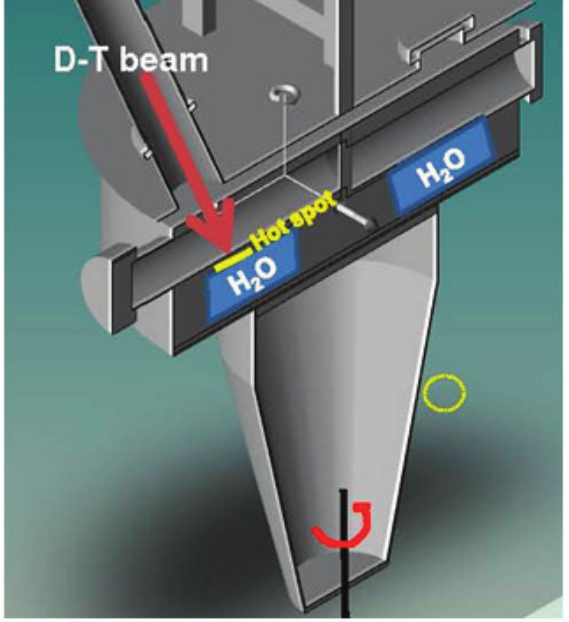
Figure 3. Schematic 3D representation of the rotating target. In operation, the cooling water is placed in the evaporator volume to extract the power load under the hot spot.